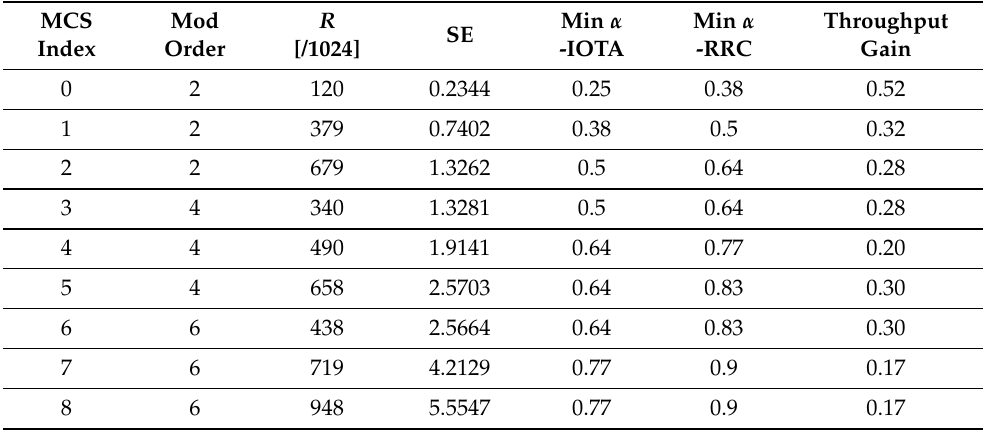
Table 4. Throughput Gains under different MCS